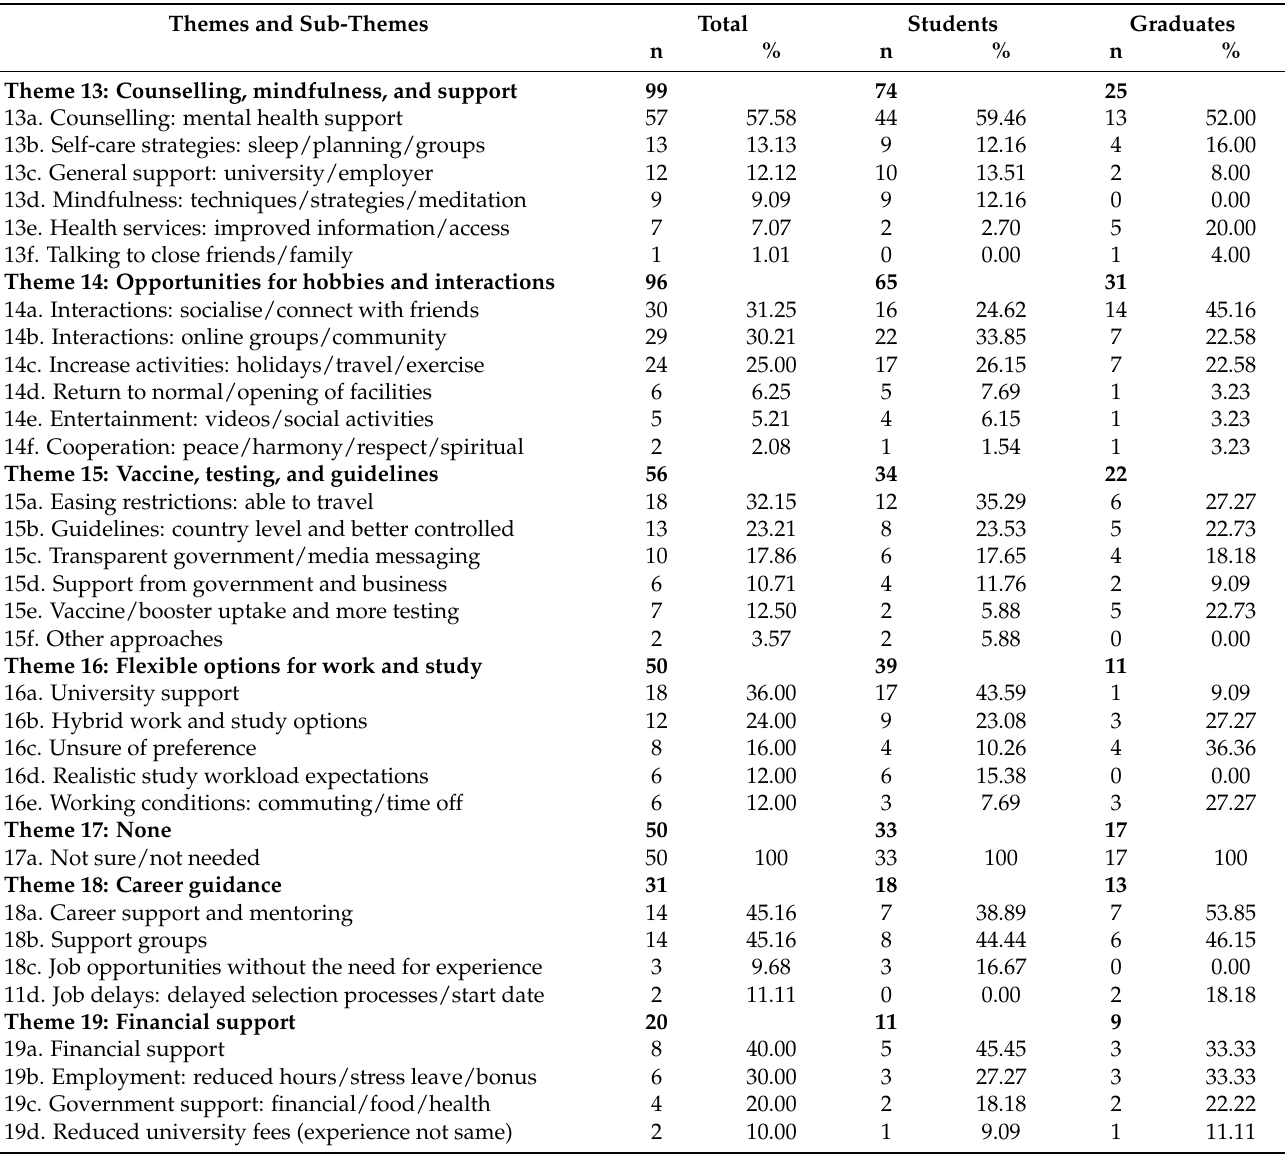
Table 8. Perceived support required to enhance subjective wellbeing (n =